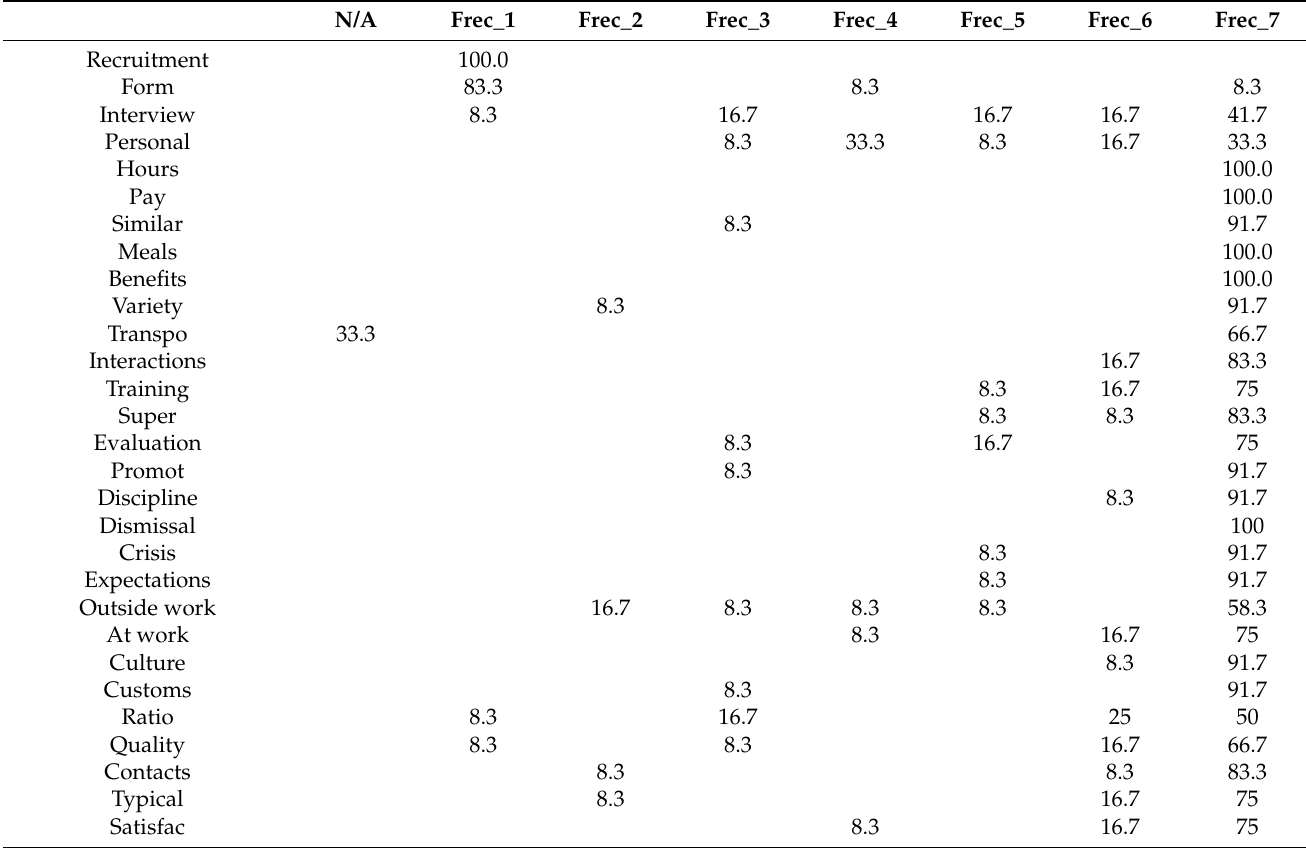
Table 9. Frequency distribution of the items on the Typicalness Questionnaire.